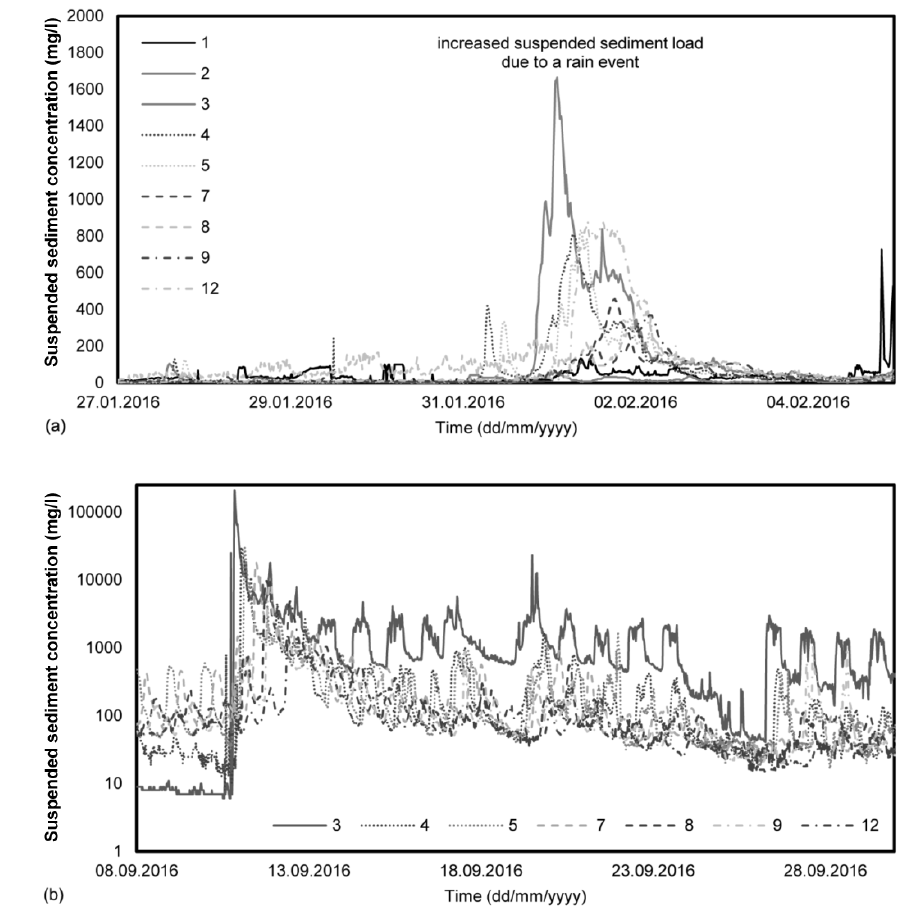
Figure 6. ( a ) Natural increase of suspended sediment concentration due to heavy rainfall and ( b ) natural increase in suspended sediment concentration based on a torrent in the tributary catchment of the Sanna River. Daily fluctuations are related to subsequent maintenance works.